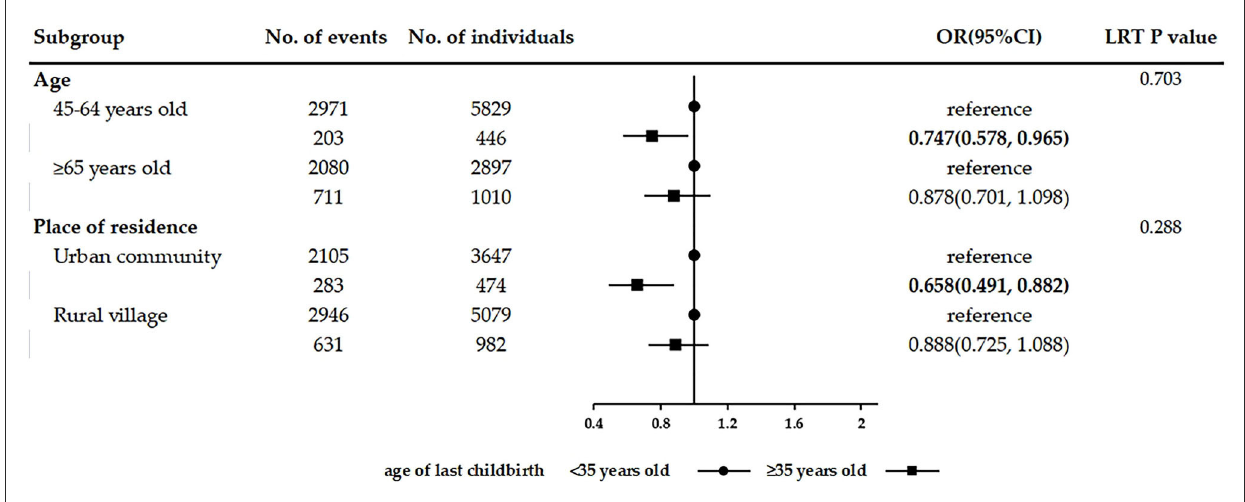
FIGURE5 Restrictive cubic splines on the association among parity, age of first childbirth, and multimorbidity. (A) Restrictive cubic splines on the association between parity and multimorbidity. (B) Restrictive cubic splines on the association between age of first childbirth and multimorbidity.